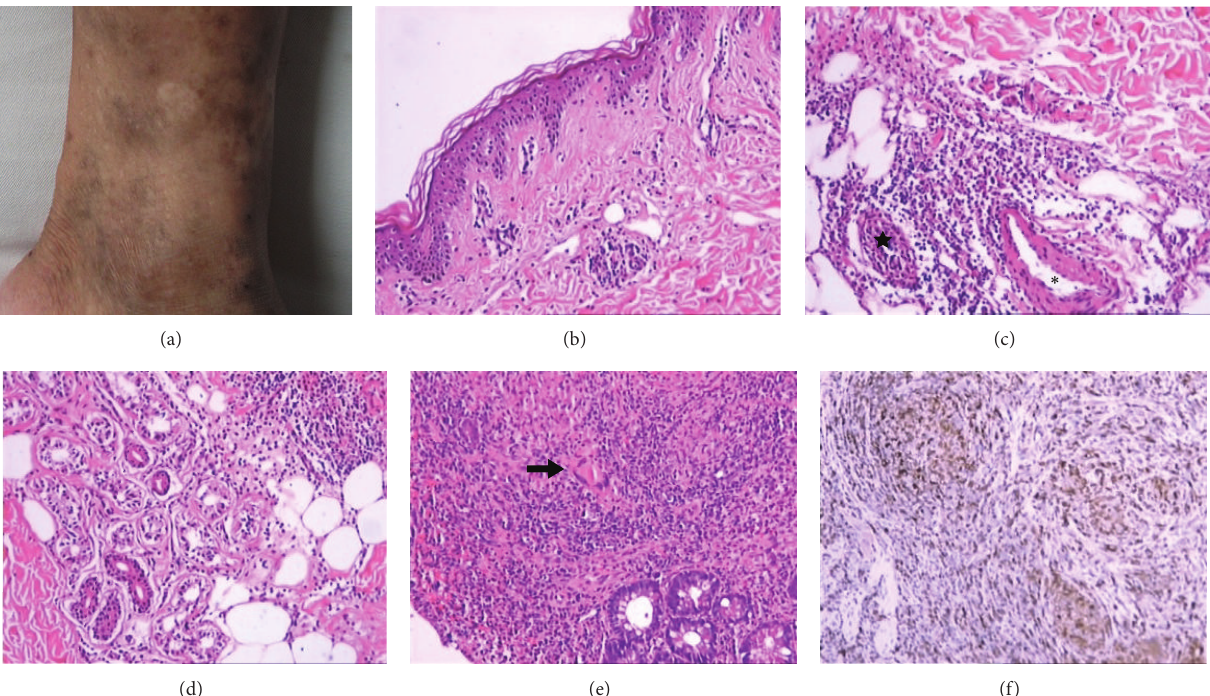
Figure 1: Skin lesions and pathologic findings. (a) A representative picture for skin nodules. ((b)–(d)) Histological examination of skin lesions showed mild atrophy of the epidermis and enormous neutrophilic and lymphocytic infiltration of adipose tissue and appendages in the dermal layer ((b), (d)); local small abscesses were formed (star) (c); in line with vasculitis, a thickening of the arterial walls of some small arteries by an inflammatory lymphoid infiltrate (snowflake) (H.E. stain × 100) (c). ((e)-(f)) Biopsy from the terminal ileum mucosa showed a granulomatous inflammatory infiltration (black bold arrow) (H.E. stain × 100) (e). Antiacid staining and PAM were negative. CD68 antigen in terminal ileum mucosa was positive ( × 100)